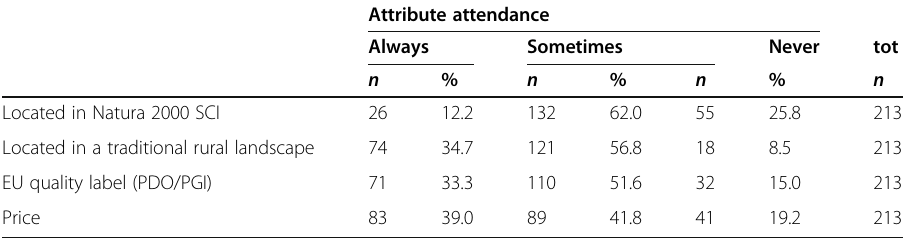
Table 5 Attendance statistics by attribute based on stated attribute attendance Attribute